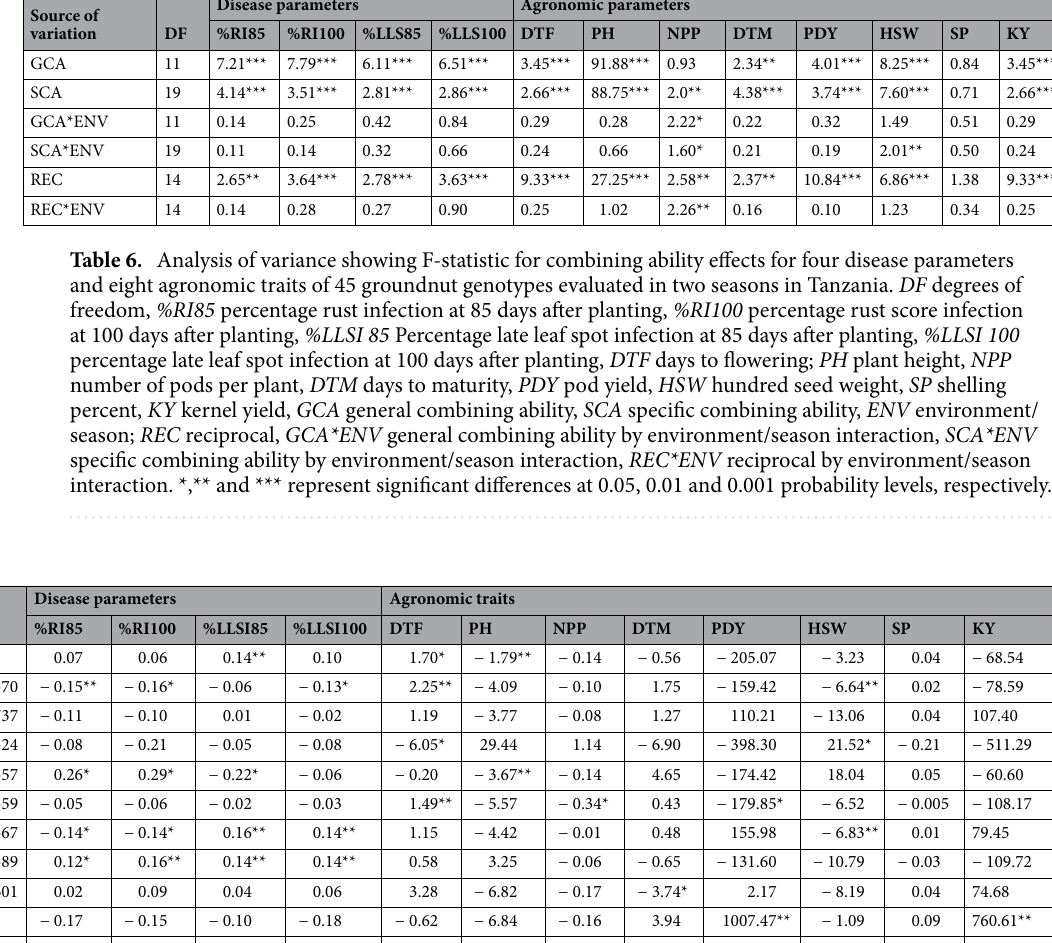
Table 7. General combining ability effects with mean squares and significant tests for four disease parameters and eight agronomic traits of 12 parental genotypes evaluated in two seasons in Tanzania. %RI85 percentage rust infection at 85 days after planting, %RI100 percentage rust score infection at 100 days after planting, %LLSI 85 Percentage late leaf spot infection at 85 days after planting, %LLSI 100 percentage late leaf spot infection at 100 days after planting, DTF days to flowering, PH plant height, NPP number of pods per plant, DTM days to maturity, PDY pod yield; HSW hundred seed weight, SP shelling percent, KY kernel yield. *,** and *** represent significant differences at 0.05, 0.01 and 0.001 probability levels, respectively.